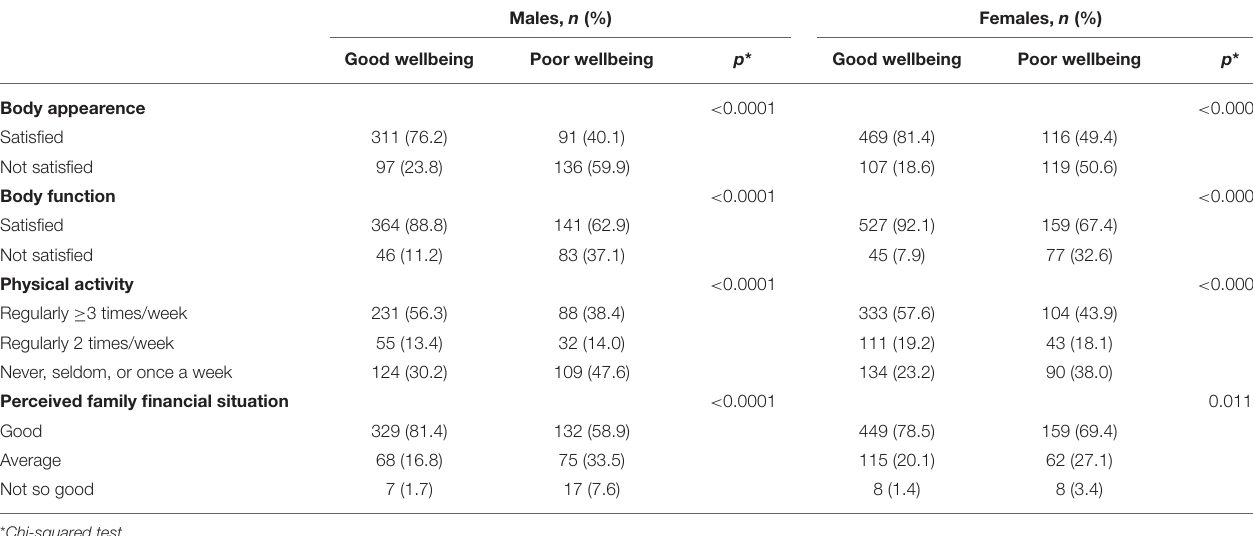
TABLE 3 | Relationship between wellbeing, body appearance, body function, physical activity, and family financial situation in male and female adolescents ( n = 1,491).